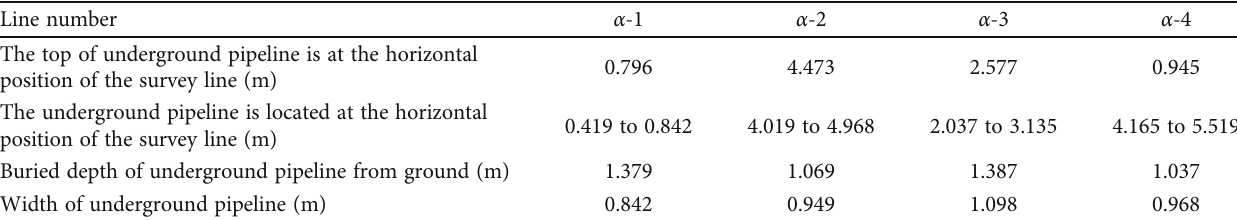
Figure 7: Detection results with two tested pipelines. Table 1: Location of underground pipelines in section α